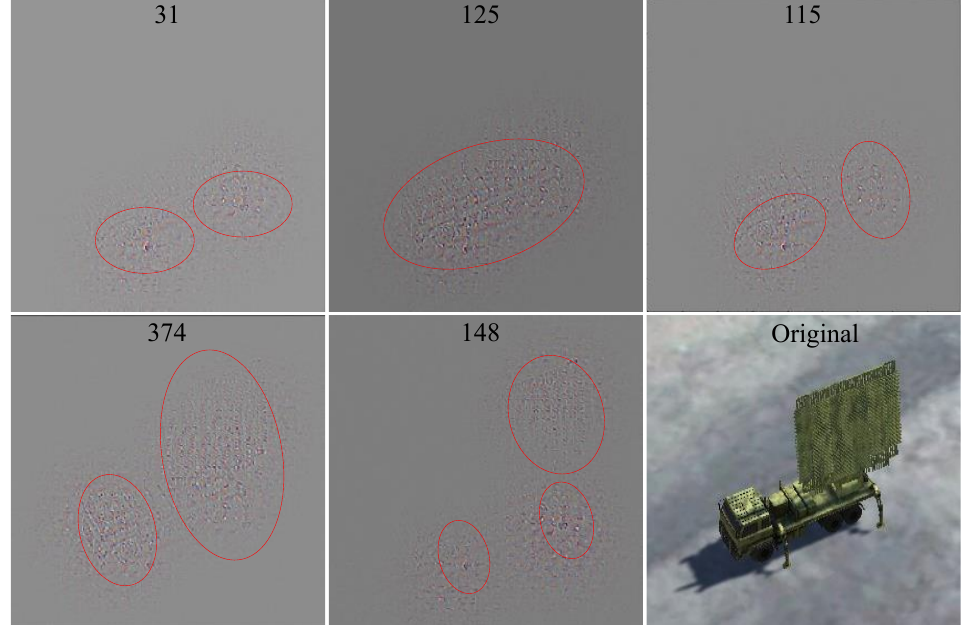
Figure 7. Deconvolution visualization of clustered convolution kernels for radar